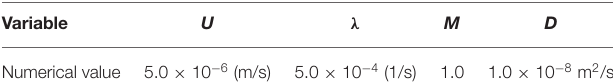
TABLE 1 | Parameters used for the benchmark test